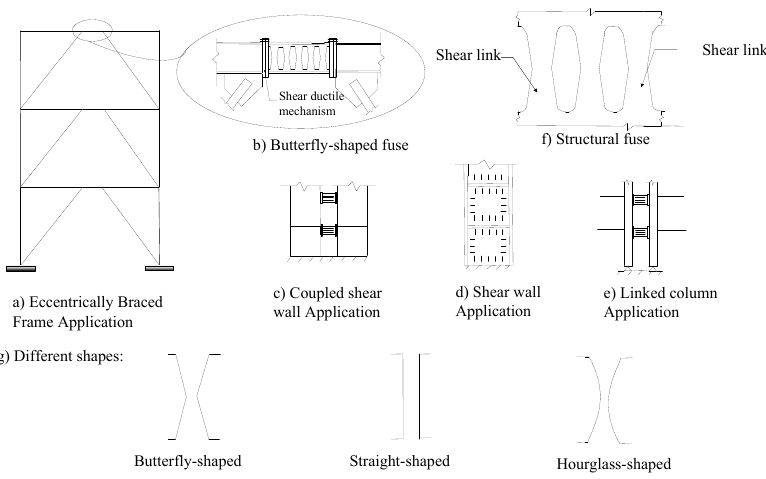
Figure 1. Structural fuse system. ( a ) Eccentrically braced system; ( b ) Butterfly-shaped fuse; ( c ) Coupled shear wall; ( d ) Shear wall; ( e ) Linked column application; ( f ) Structural fuse; ( g ) Different shapes.